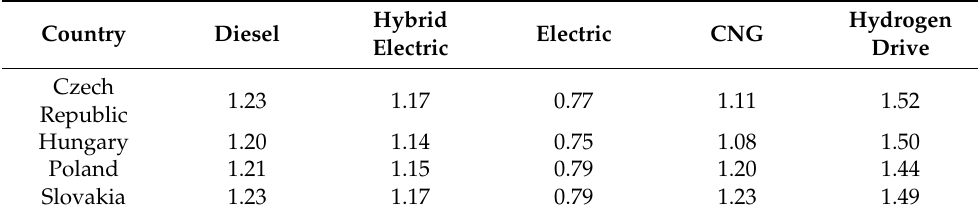
Table 16. Cost of a vehicle-kilometer of mega buses (18 m) with different drive types in the V4 countries, calculated on the basis of the first year of operation (2021) ( € ). Country Diesel